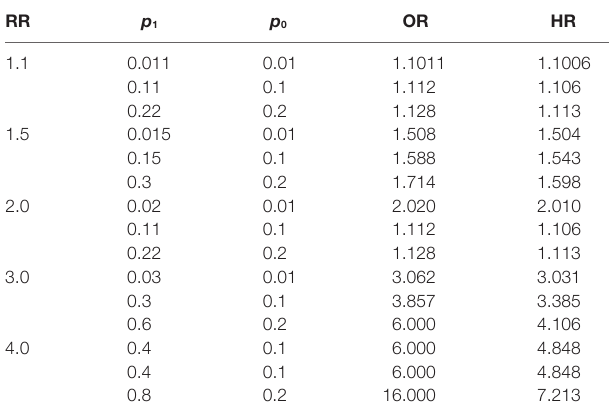
TABLe 11 | Analysis of maximum likelihood estimates. Parameter